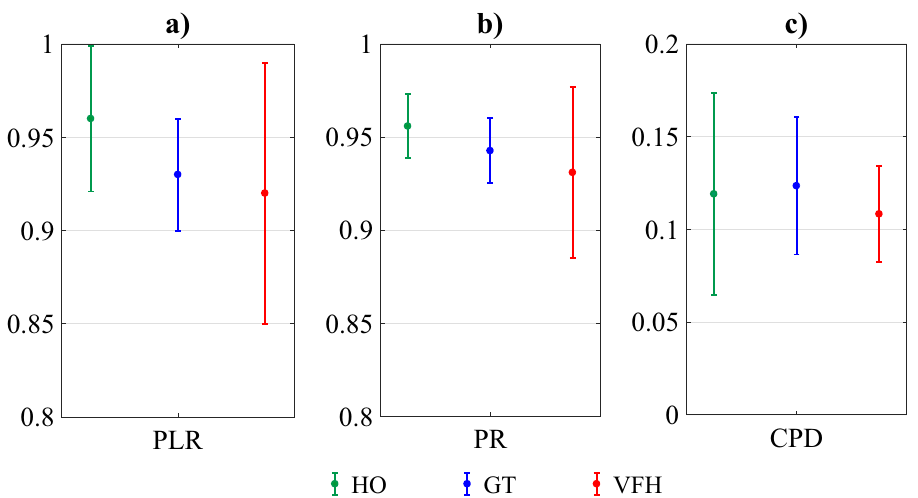
Figure 4. Mean value and standard deviation for each experimental condition considering each performance parameter. The three experimental conditions are: HO—video with human only; GT—video with humans and a robot driven by our game-theoretical trajectory planner; VFH—video with humans and a robot driven by the Enhanced Vector Field Histogram algorithm. The performance parameters are: ( a ) PLR (Path Length Ratio) — the average of the ratio of the line of sight path distance between the start and goal and the real agent’s trajectory; ( b ) PR (Path Regularity) —the average regularity of the agent’s trajectory; ( c ) CPD (Closest Pedestrian Distance) —the average distance between the agent and the closest